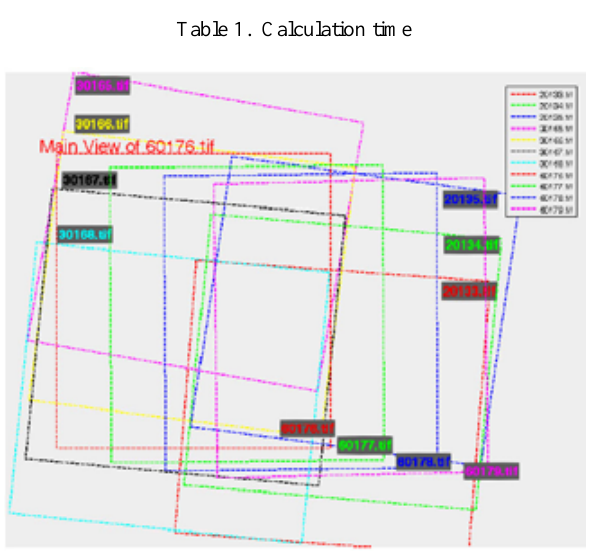
Figure 7. Image overlap determined by AFTP for the 11 test